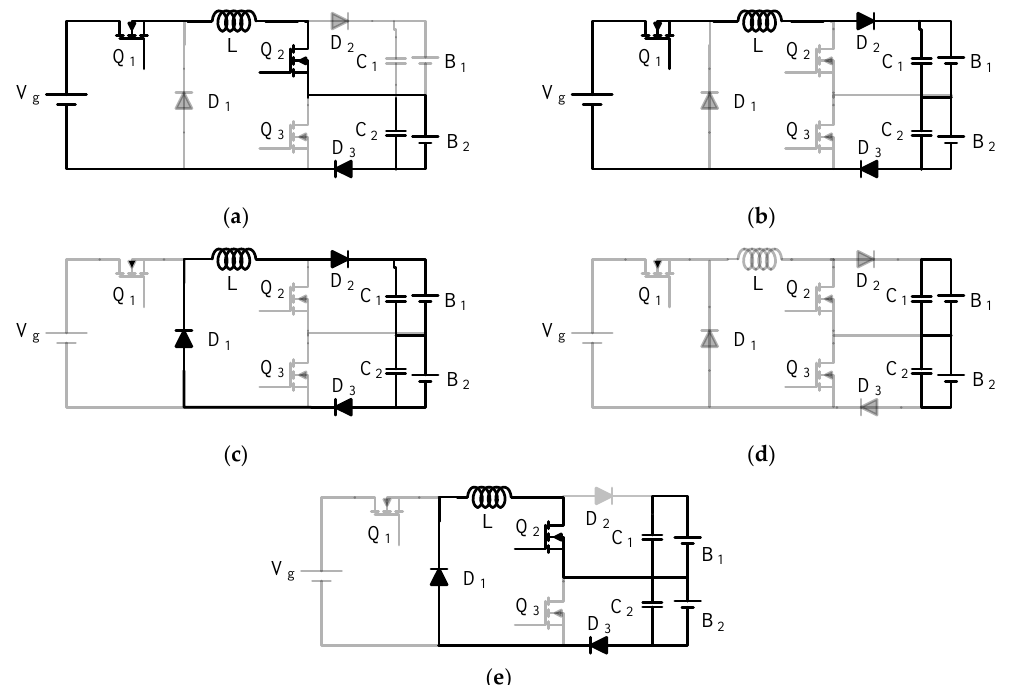
Figure 3. Waveforms of proposed converter for lower charging current to battery B 1 at ( a ) d 2 < d 1 , ( b ) d 2 > d 1 .